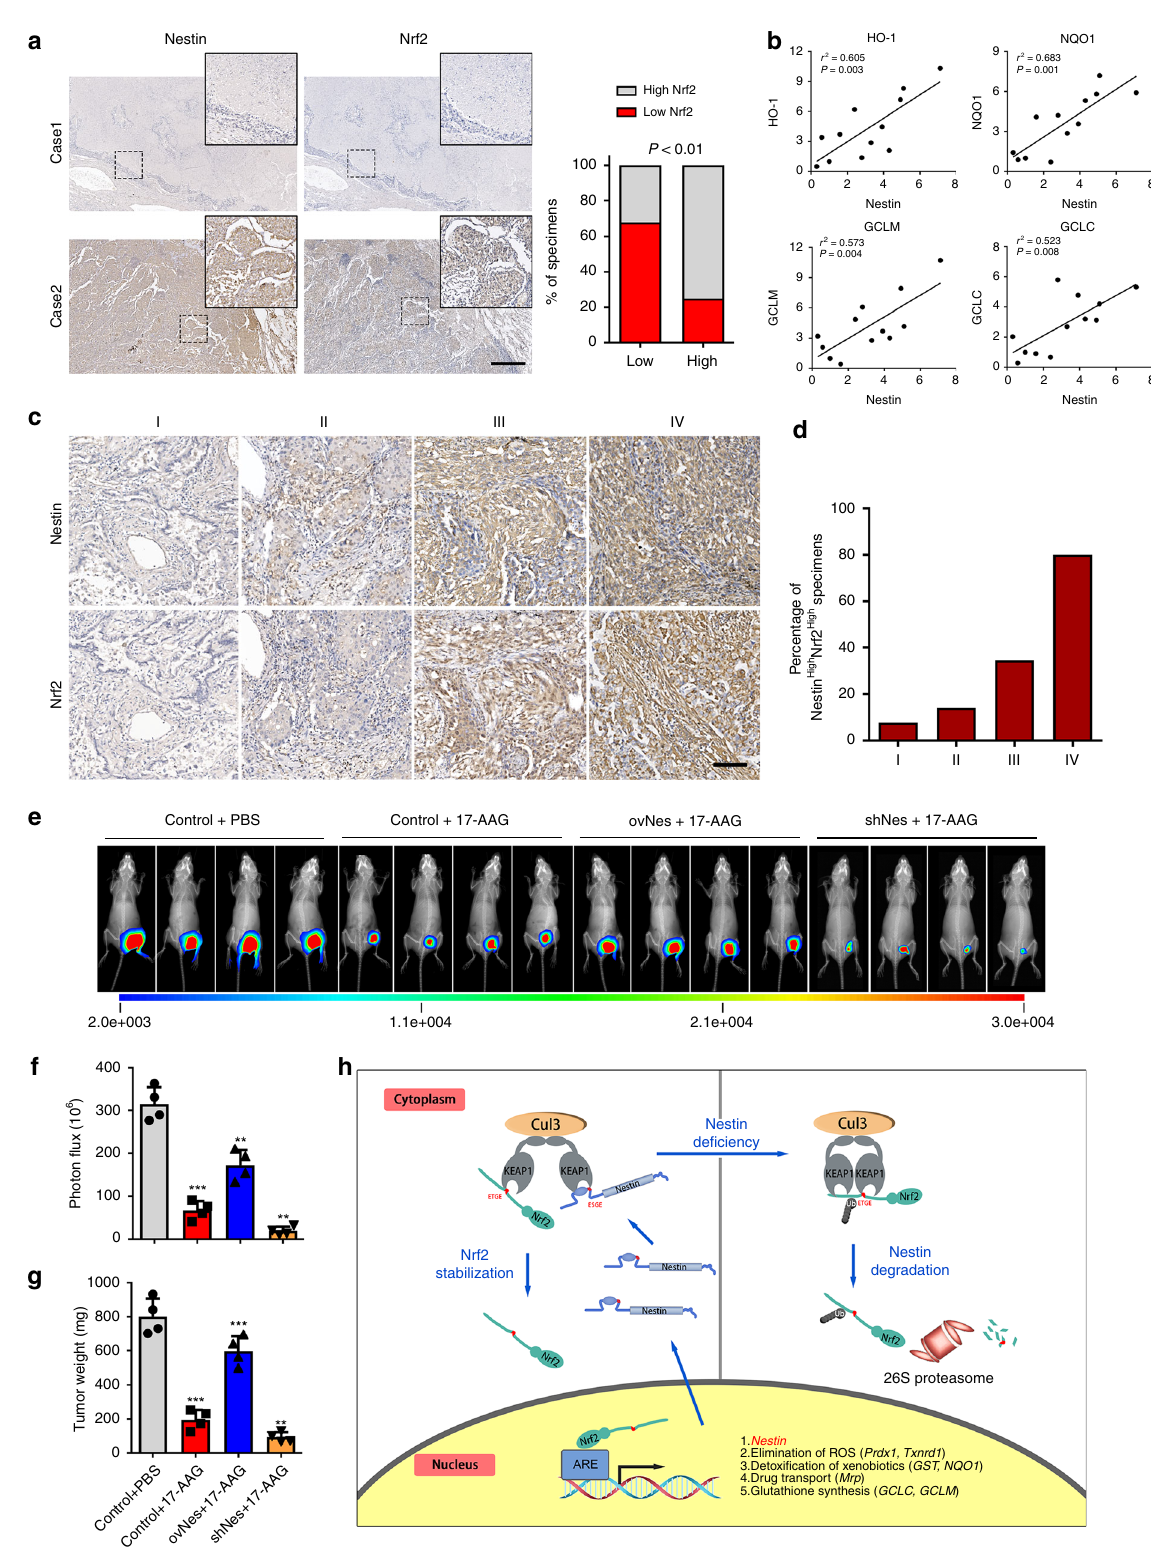
20 μ g of protein was denatured and resolved by SDS/PAGE, then transferred to PVDF membranes (Millipore). The target proteins were immunoblotted with the speci fi c antibodies. The antibodies used can be found in the Supplementary Table 4. Chemiluminescent substrate (Millipore) was used for detecting the sig- naling intensity. For cytoplasm and nuclear protein separation, the Subcellular Protein Fractionation Kit (Thermo) was applied for distinguishing the cytoplasm and nuclear protein. The collected proteins were submitted for